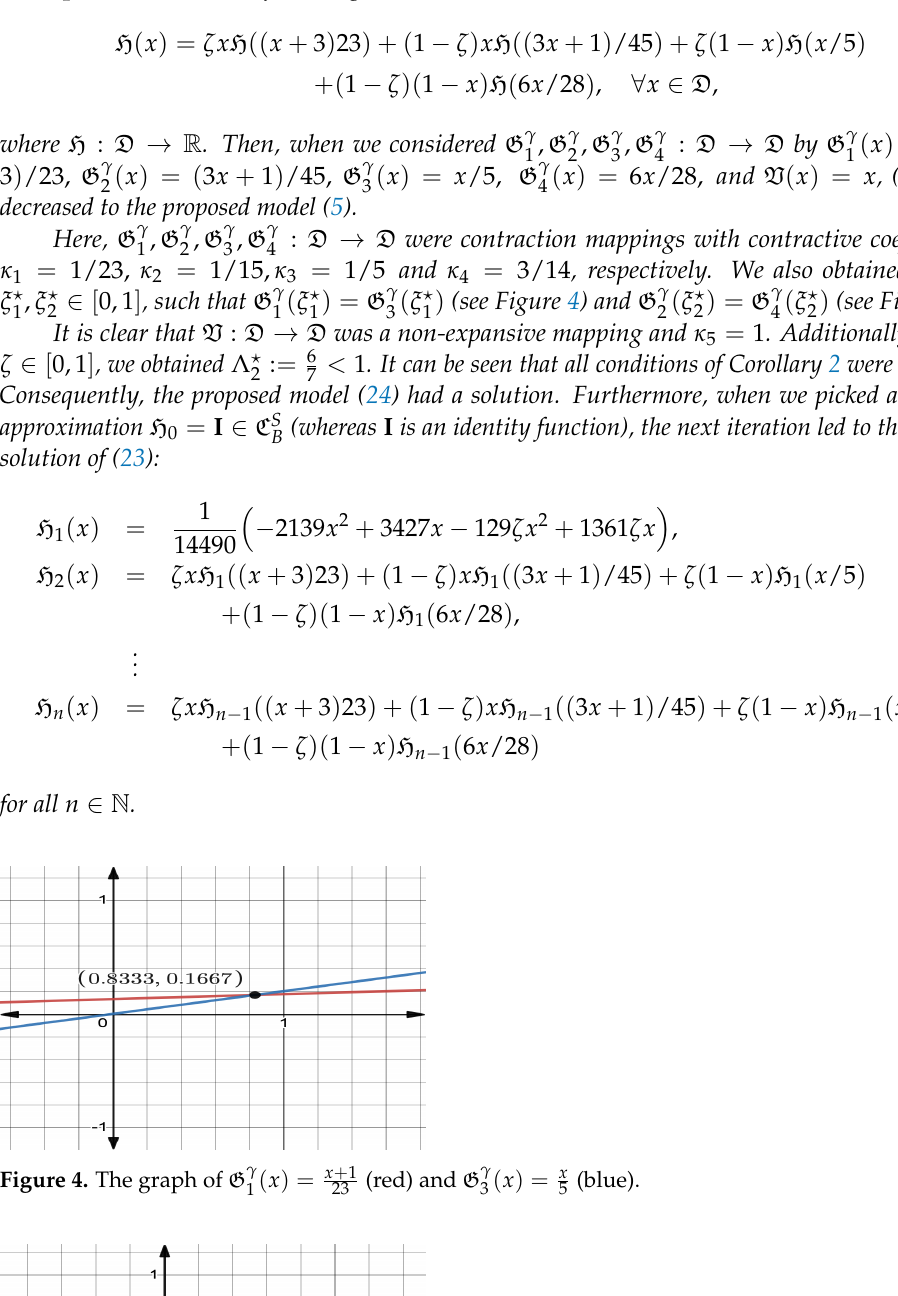
Figure 4. The graph of G γ